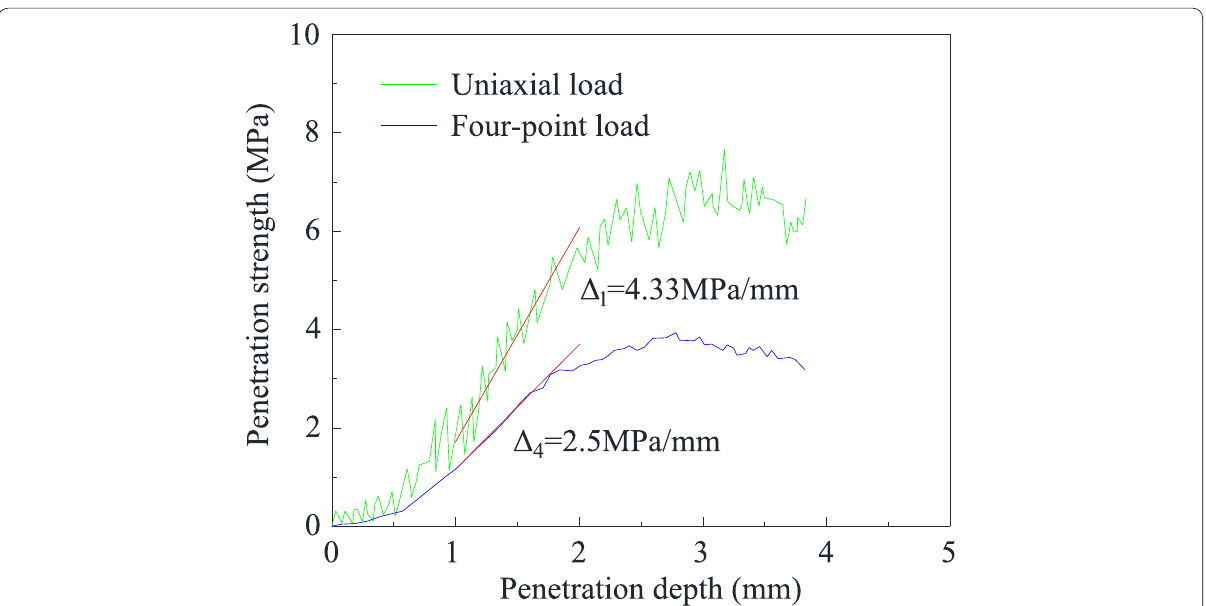
Fig. 7 Uniaxial and four-point penetration shear curves of SMA-13 mixture